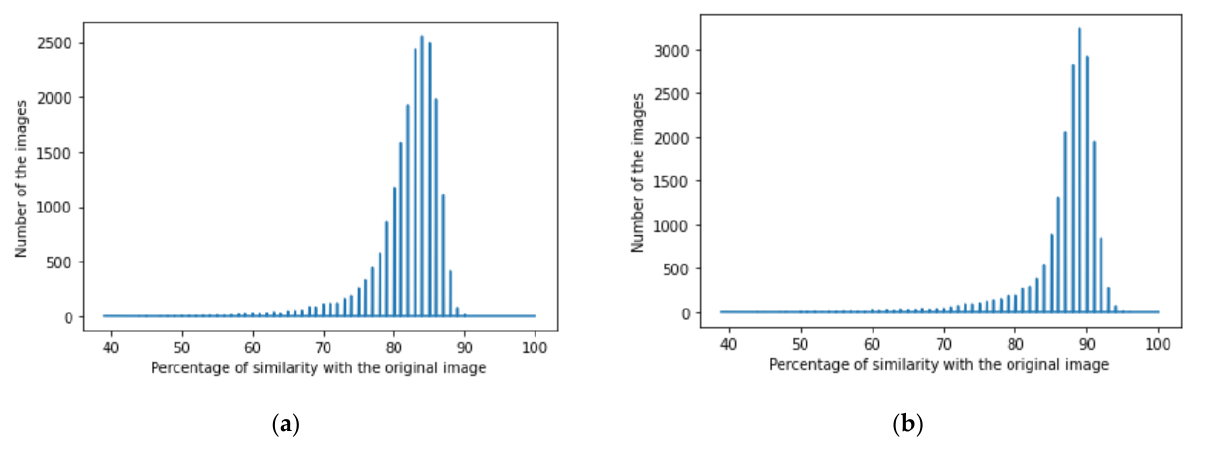
( b ) Figure 10. The histogram of similarity between the predicted denoised image and the original image in the case of speckle noise: ( a ) one autoencoder with separable convolutional neural networks; ( b ) dual autoencoder with separable convolutional neural networks. ( a ) ( b ) Figure 11. The histogram of similarity between the predicted denoised image and the original image in the case of impulse noise: ( a ) one autoencoder with convolutional neural networks; ( b ) dual au- toencoder with convolutional neural networks.